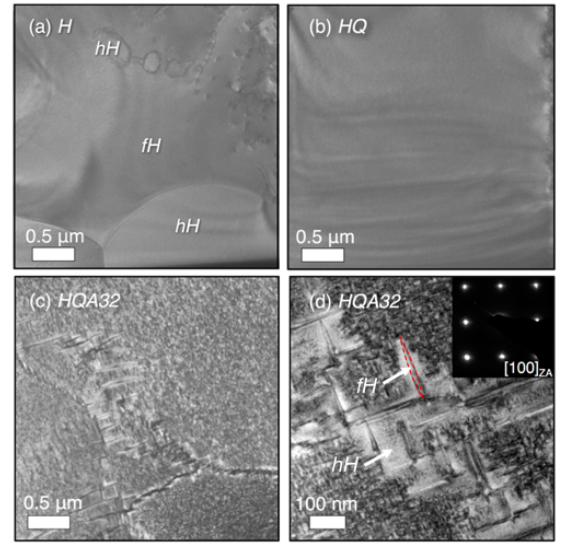
Figure 6. Transmission electron micrographs showing microstructural evolution in samples ( a ) H , ( b ) HQ and ( c , d ) HQA32 . (a) The homogenized sample contains separate TiNiSn and TiNi 2 Sn regions on the micron scale; (b) quenching from a high temperature again reveals a single phase with excess Ni; (c,d) bright field images (along the [100] zone axis, shown by the inset in (d)) of HQA32 show the Heusler phase precipitates out at the nanoscale, forming along (cid:104) 100 (cid:105) directions of the half-Heusler matrix, with larger precipitates forming along low angle grain boundaries. One of these larger precipitates is outlined in red. The mottled contrast in (c,d) is due to smaller scale